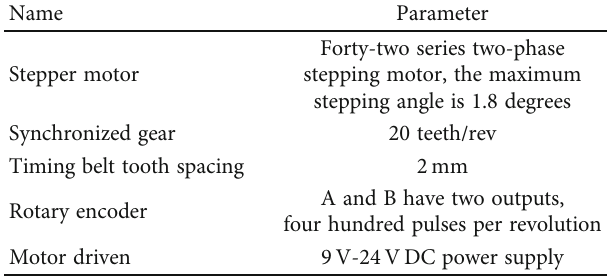
Table 2: Parameters of one-dimensional slide table. Name